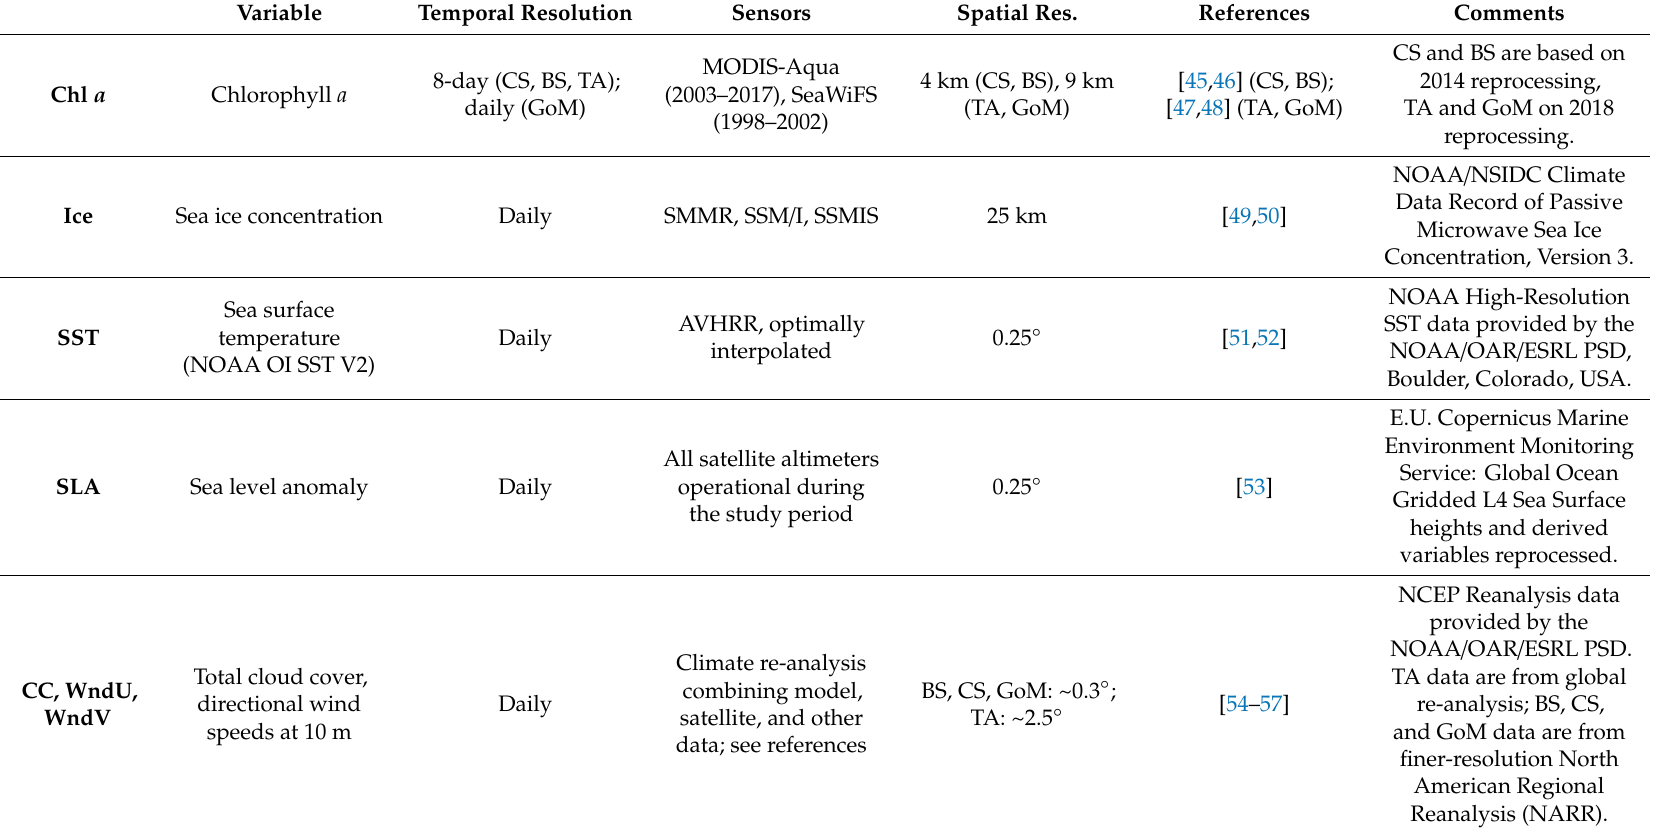
Table 2. Overview of raw data sources. All data were mosaicked into 8-day (BS, CS, tropical Atlantic (TA)) or 3-day composites (Gulf of Mexico (GoM)), and resampled to the Chl a grid (BS, CS: 4 km spatial resolution; TA, GoM: 9 km spatial resolution). All data were downloaded on 17 August 2017 (BS, CS), 20 September 2018